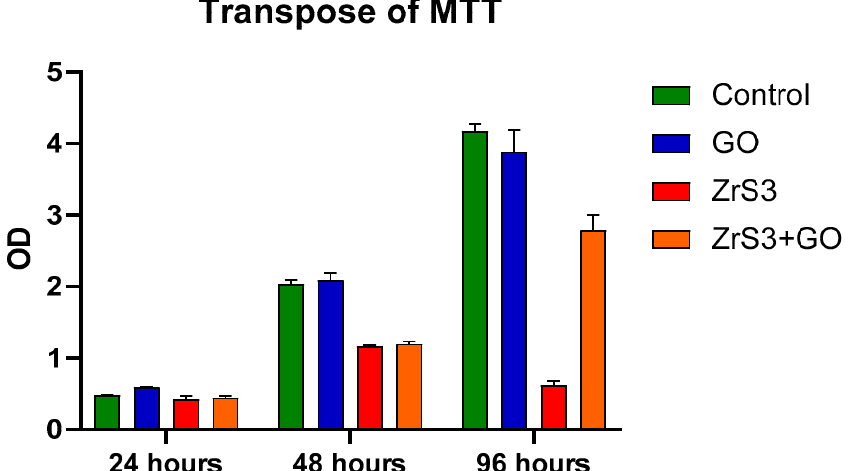
Figure 6. Proliferation of HCT116 cells on nanostructured films (control, GO, ZrS 3 , ZrS 3 +GO).